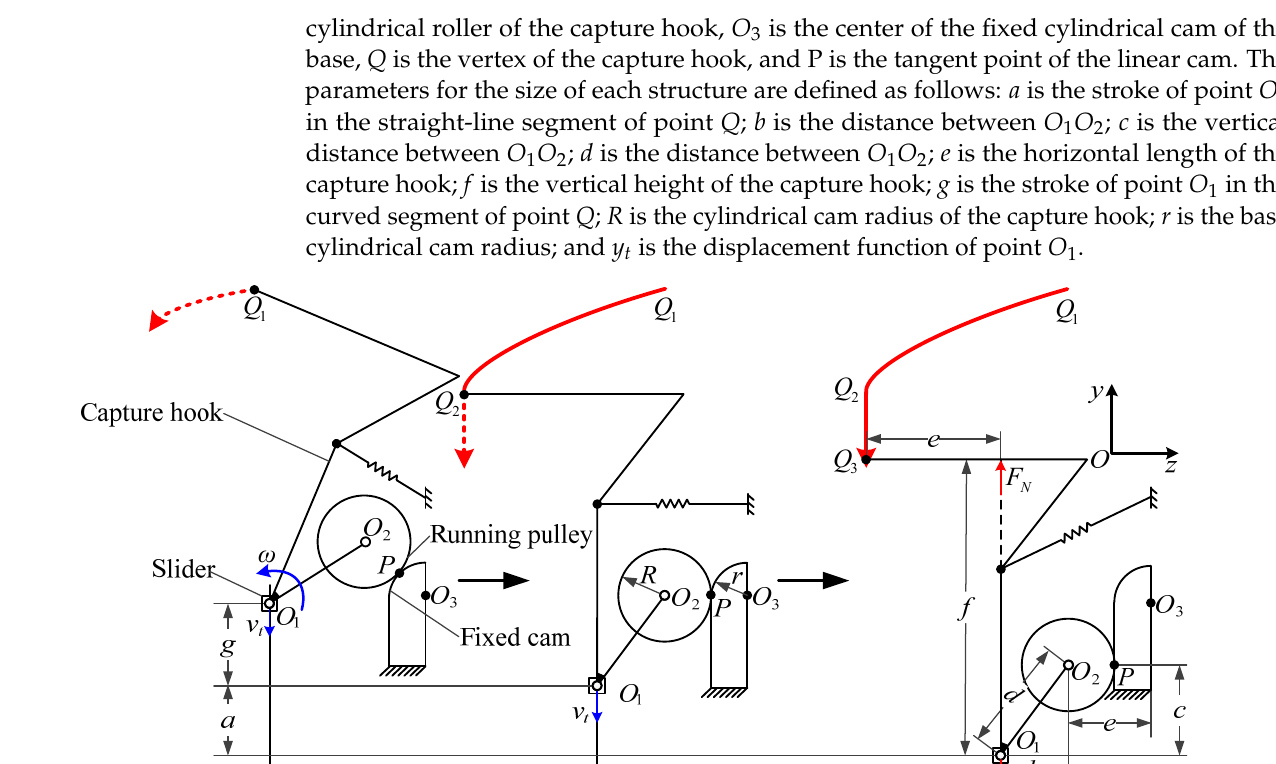
( b ) Figure 15. Schematic diagram of the capture scheme ( a ) Released state; ( b ) locked state. 1, capture box; 2(the red dotted line), capture hook vertex trajectory; 3, positioning axis; 4, V-groove; 5, capture hook.